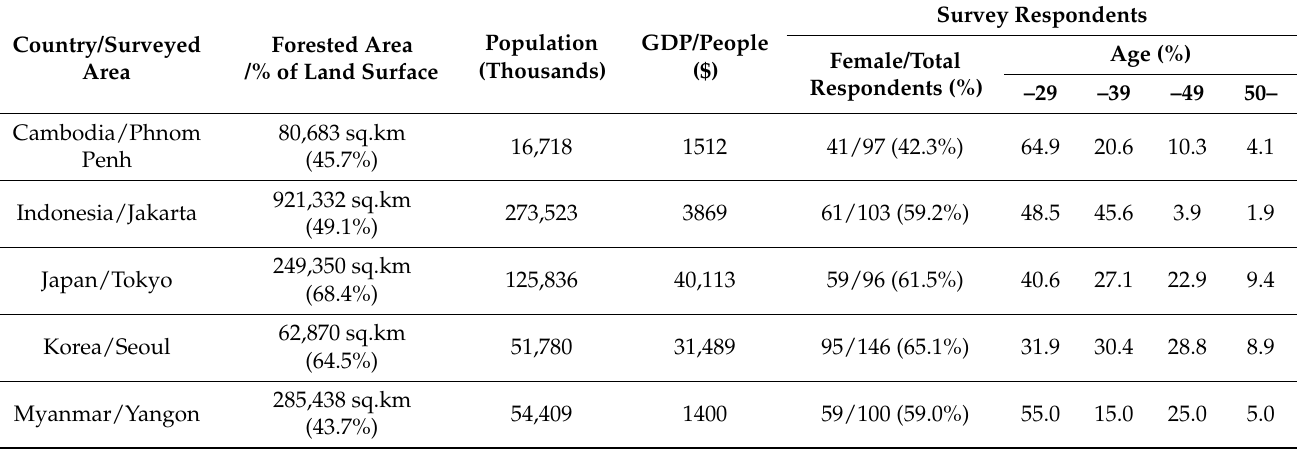
Table 1. General characteristics of the survey respondents in each